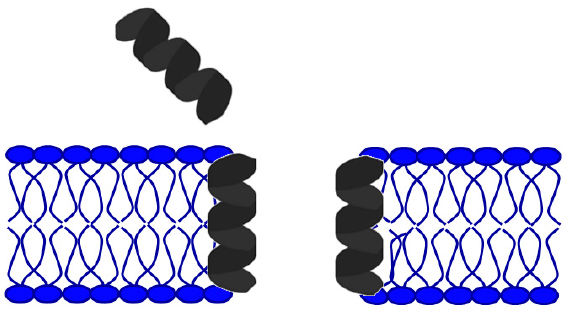
Figure 2. Barrel–stave pore model.